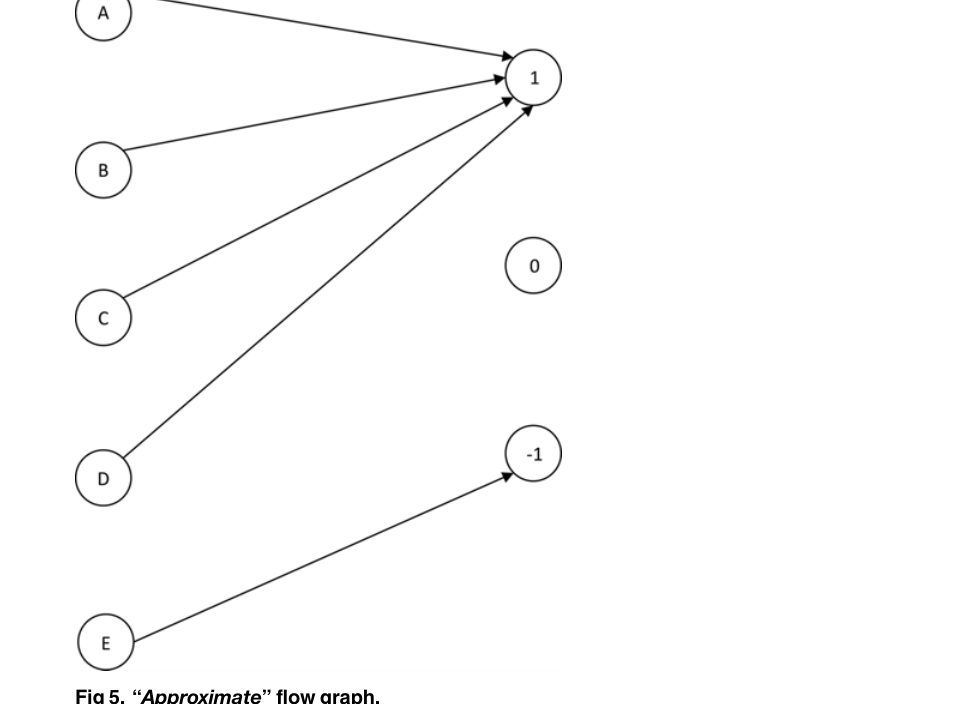
Fig 5. “ Approximate ” flow graph.